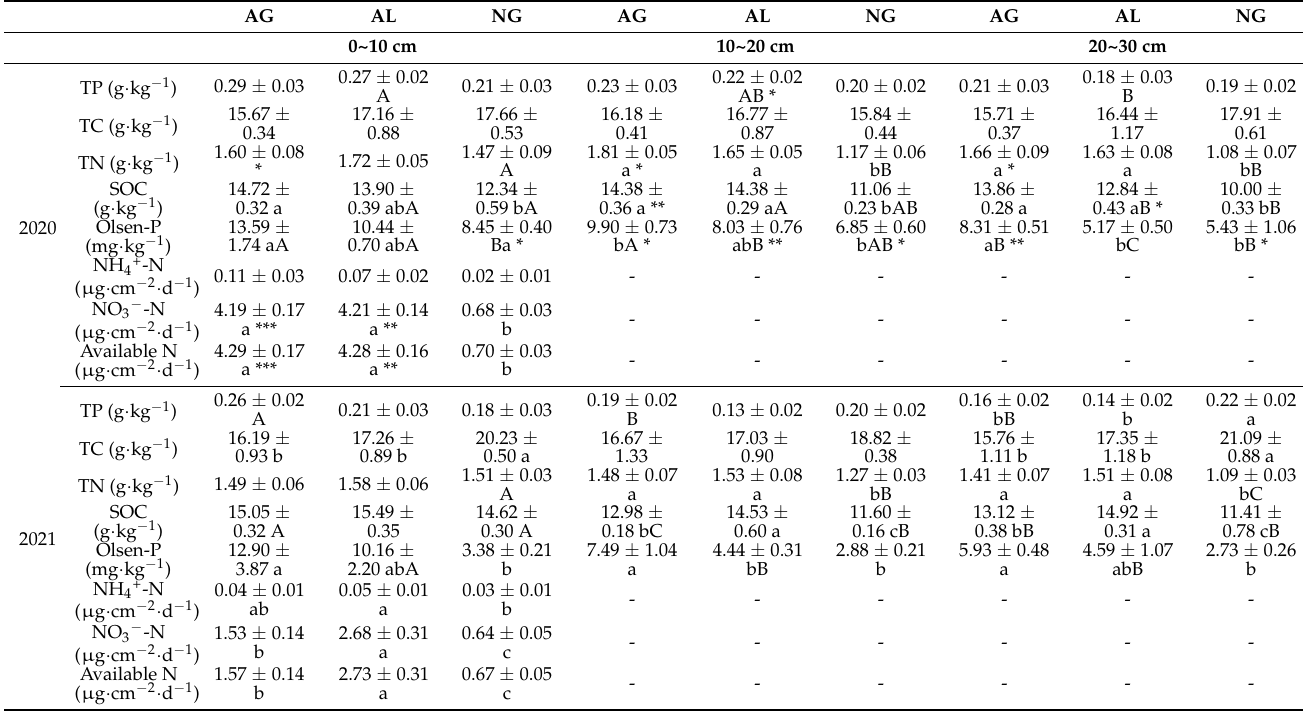
TP: soil total phosphorus content; TC: soil total carbon content; TN: soil total nitrogen content; SOC: soil organic carbon content; Olsen-P: soil available phosphorus content; NH 4+ -N: soil ammonium nitrogen content; NO 3 − -N: soil nitrate nitrogen content; Available N: soil available nitrogen content; AG: artificial grassland; AL: cropland; NG: natural grassland. Lowercase letters indicate the significant difference between different land use type in the same year and soil depth, capital letters indicate significant differences between different soil layers under the same land use type and year ( p < 0.05). The asterisk indicates a significant difference between two years for the same land use type and soil layer. *, **, *** represent p < 0.05, p < 0.01, p < 0.001, respectively. Data are shown as mean ±